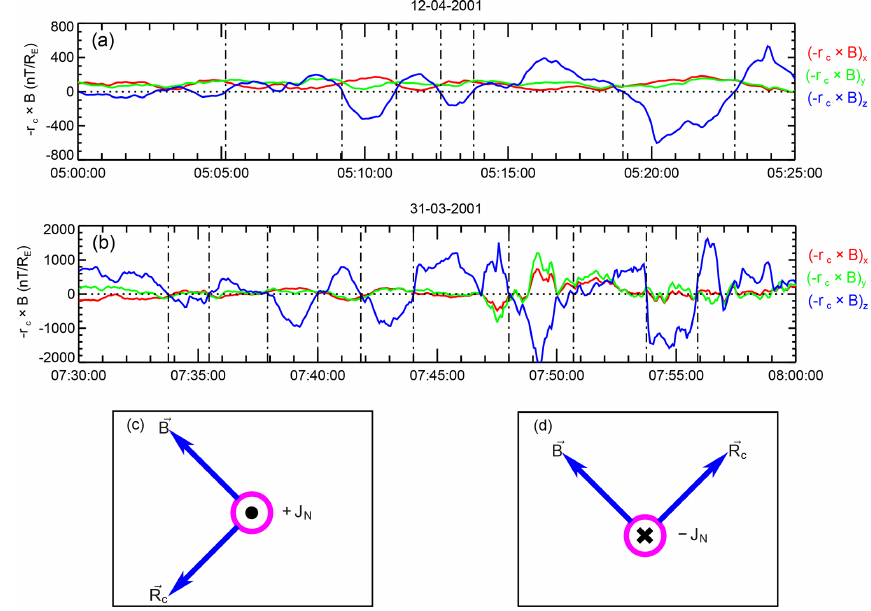
Figure 5. (a, b) The three components of − ρ c × B for two analyzed events. ρ c is calculated from MRA method, and B is the averaged magnetic field measured by four Cluster spacecraft. (c, d) Graphic plots of the origin of the j N current variation.